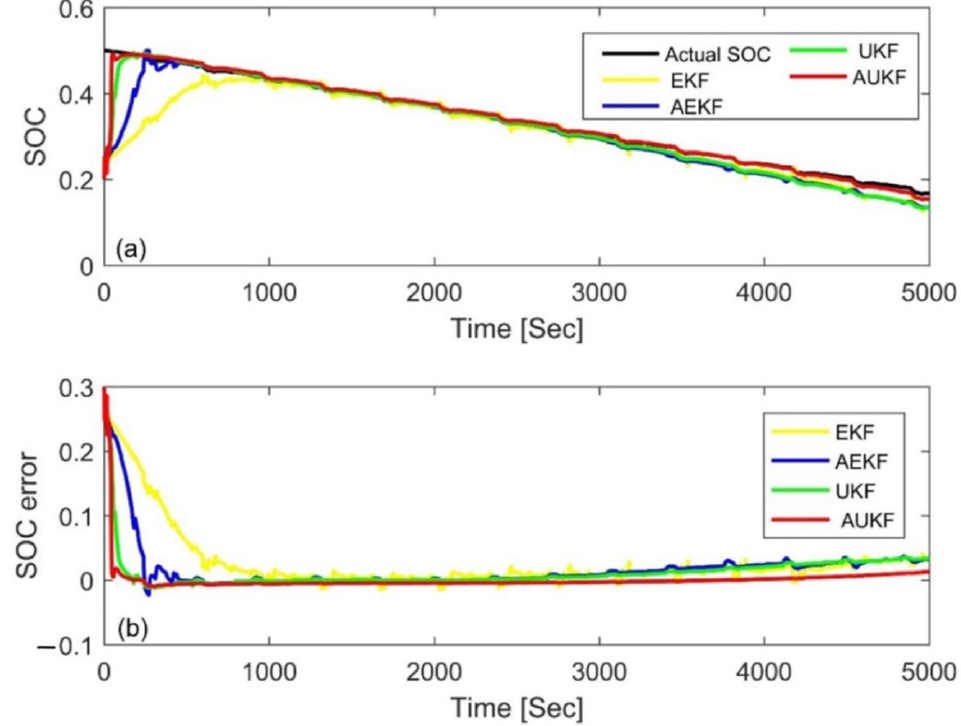
Figure 17. Estimation results at an initial SOC of 20% via the DST. ( a ) SOC estimation comparison curve; ( b ) SOC estimation error. Table 7. Comparison results of the four calculation methods via the DST.